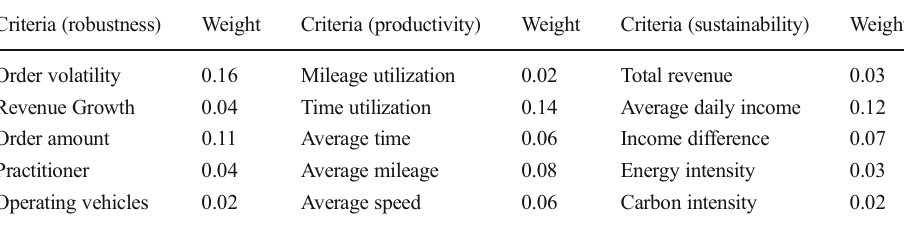
Table 6 Criteria weights derived from